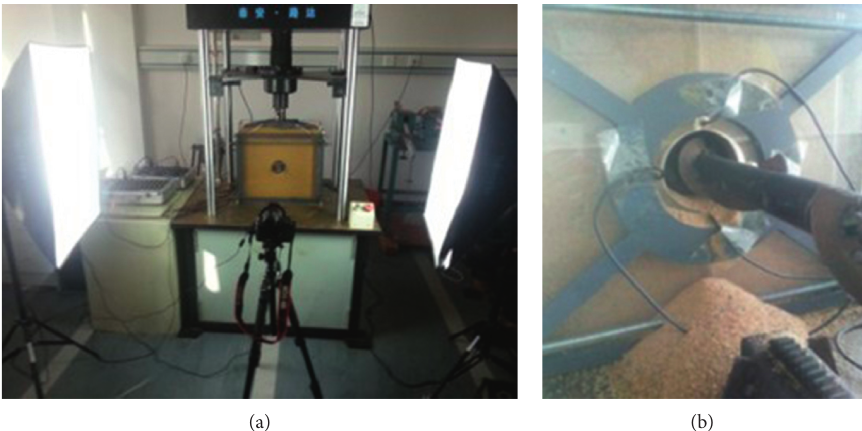
Figure 7: Roadway excavation and loading. (a) Test preparation. (b) Modeled excavation.